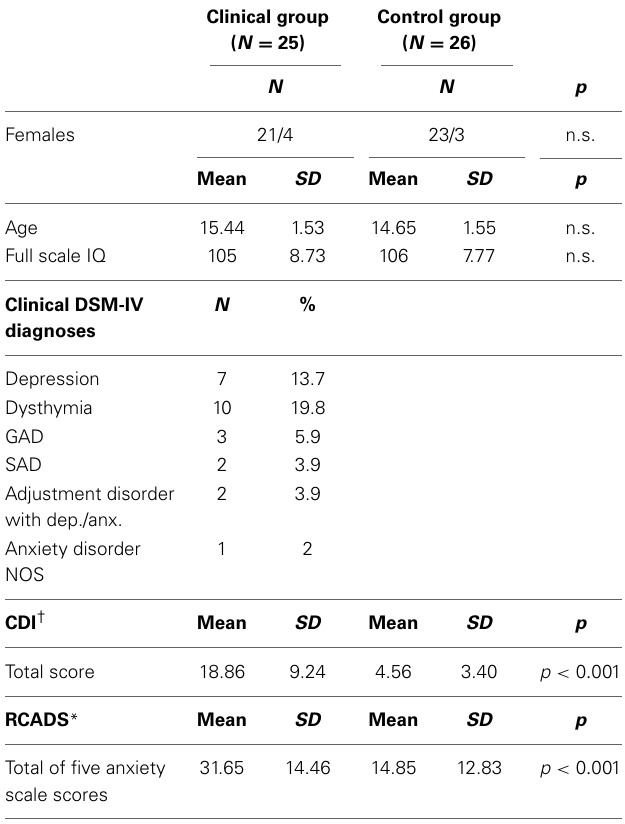
Table 1 | Group characteristics for the clinical and control